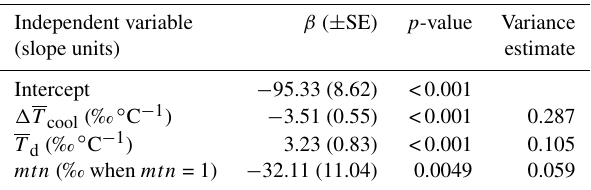
Table 1. Response variable: δ 2 H. Variation in δ 2 H is explained by a multiple linear regression ( R 2 = 0 . 54) of air parcel cooling dur- ing transport ( (cid:49)T cool ), moisture source conditions ( T d ), and oro- graphic obstacles in the vapor transport path ( mtn ). Values of β are the partial coefficients of the regression, and SE is the standard error. The variance estimate for each explanatory variable is calcu- lated as the square of the semi-partial correlation for that variable with δ 2 H. The variances reported do not sum to the total variance explained because the explanatory variables are not perfectly or-